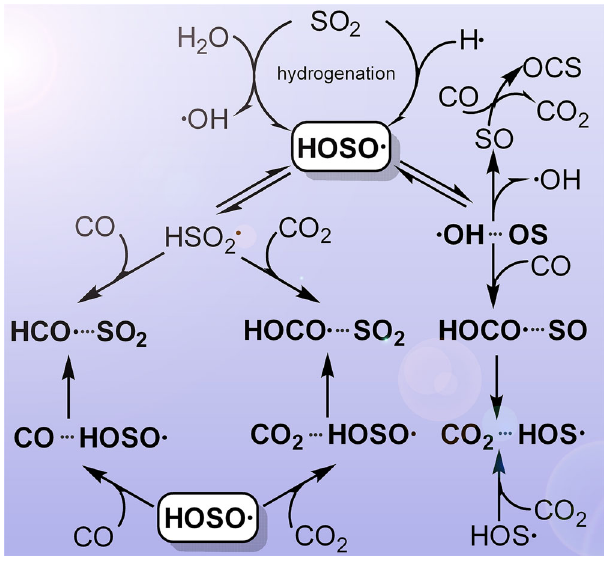
Fig. 1 | Photochemistry of HOSO • in solid CO and CO 2 ices. Proposed pathways for the photo-induced decomposition, isomerization, and hydrogen atom trans- fer reactions of HOSO • in solid CO and CO 2 at 16